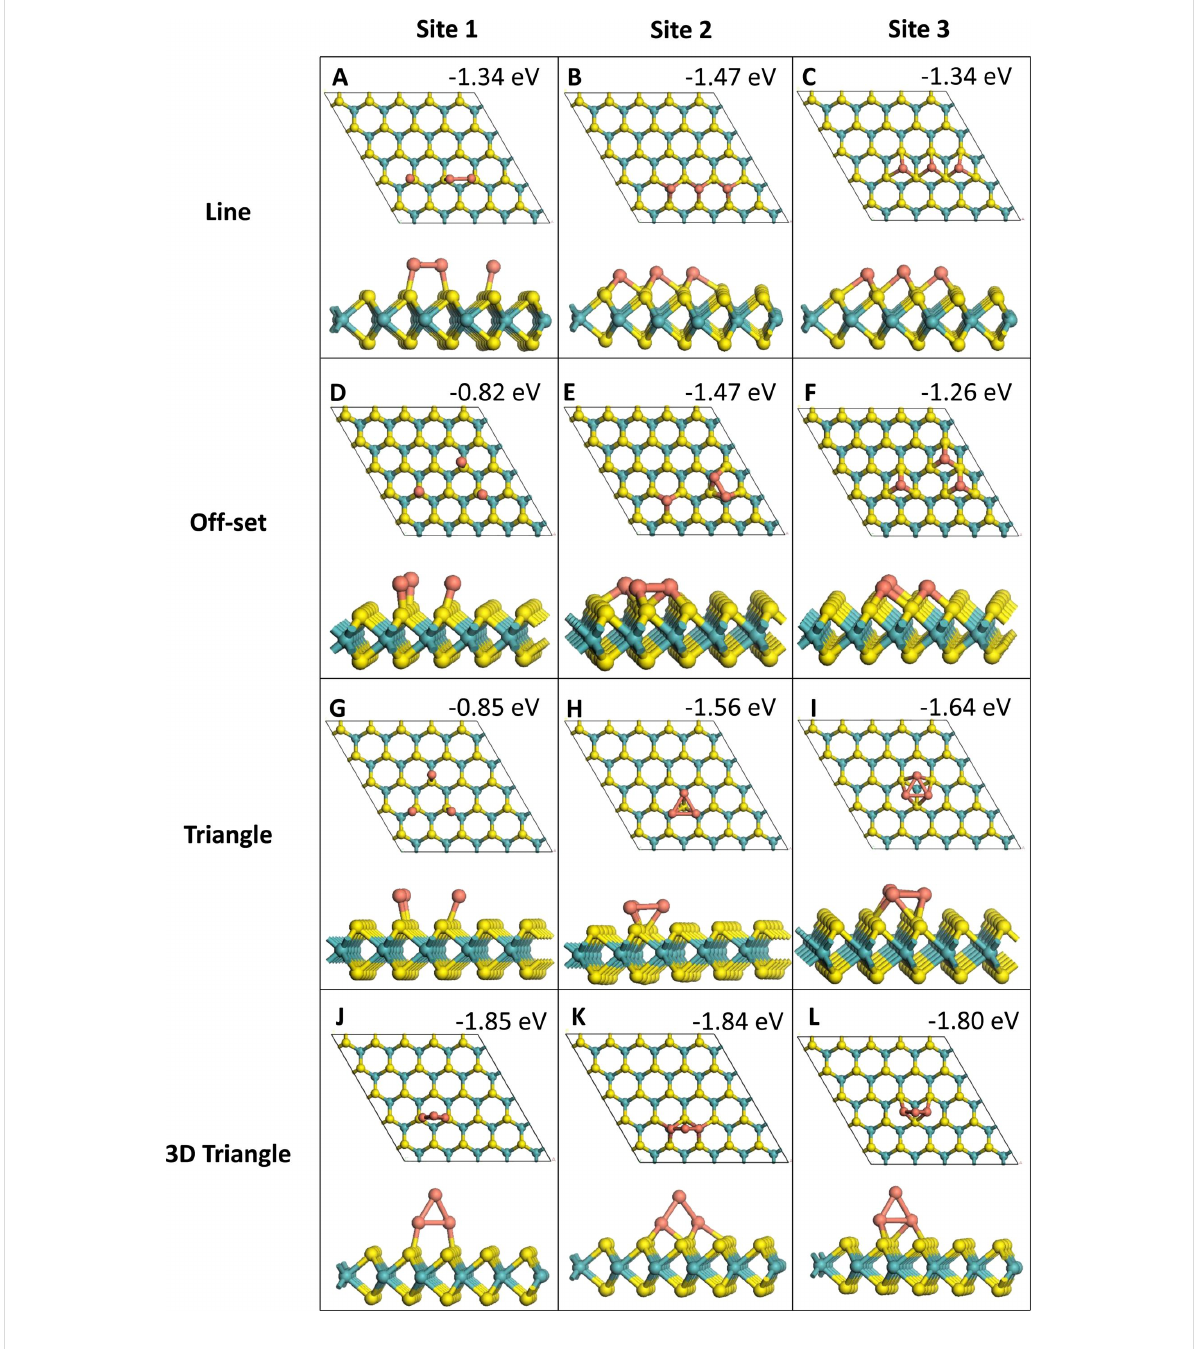
Figure 3: Relaxed structures after adsorption of Cu 3 structures.